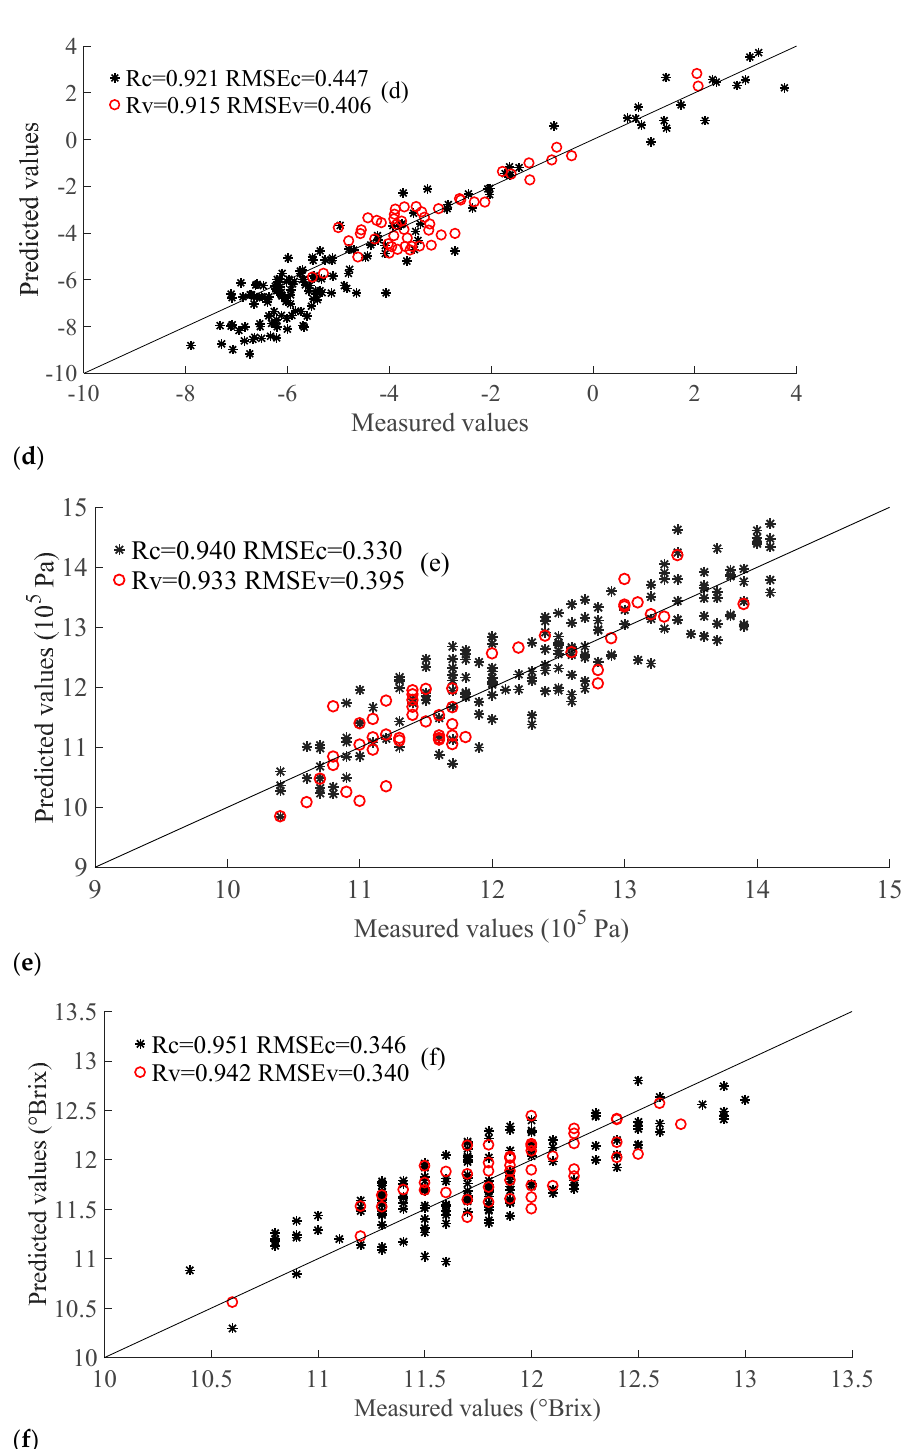
Figure 8. Scatter plots of the calibration set (*) and prediction set (o) for each quality parameter. ( a ). Scatter plots of the LS-SVM mold of the a* value. ( b ). Scatter plots of the LS-SVM mold of the firmness. ( c ). Scatter plots of the LS-SVM mold of the SSC. ( d ). Scatter plots of the PLSR mold of the a* value. ( e ). Scatter plots of the PLSR mold of the firmness. ( f ). Scatter plots of the PLSR mold of the SSC.